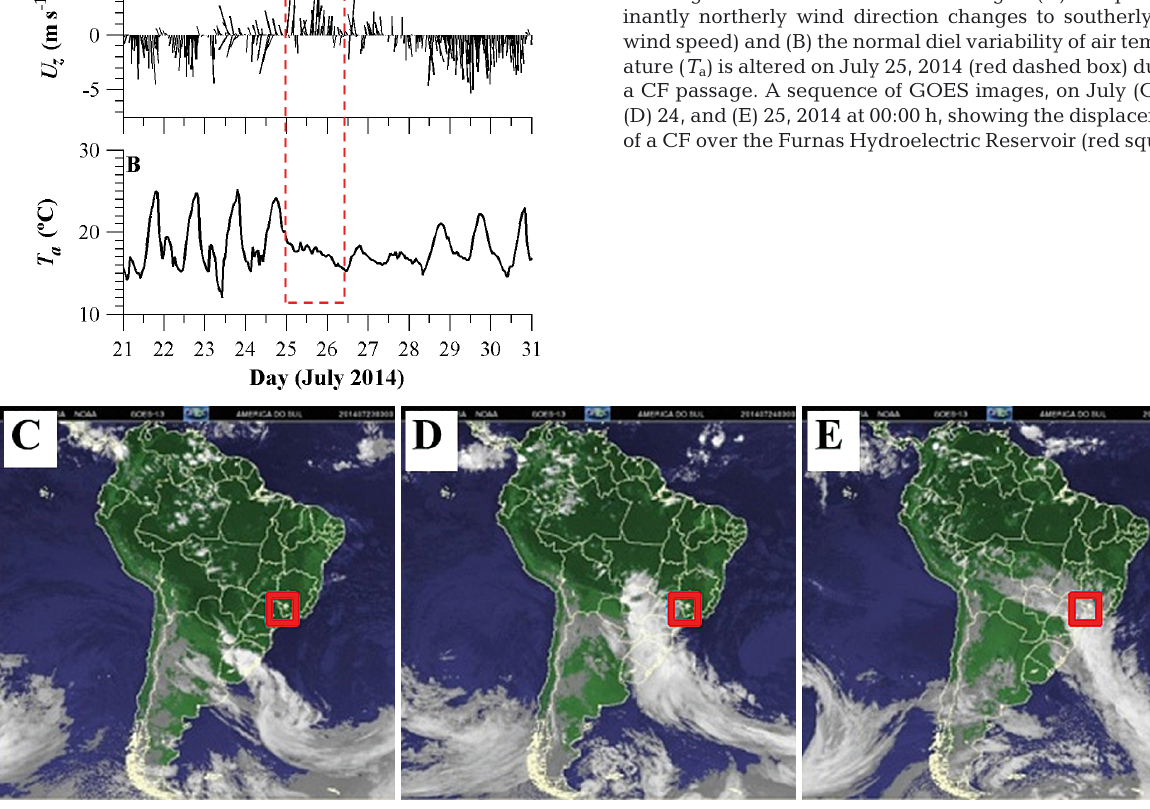
Fig. 2. Example of a cold front (CF) identified based on me- teorological variables and satellite images. (A) The predom- inantly northerly wind direction changes to southerly ( U z : wind speed) and (B) the normal diel variability of air temper- ature ( T a ) is altered on July 25, 2014 (red dashed box) during a CF passage. A sequence of GOES images, on July (C) 23, (D) 24, and (E) 25, 2014 at 00:00 h, showing the displacement of a CF over the Furnas Hydroelectric Reservoir (red